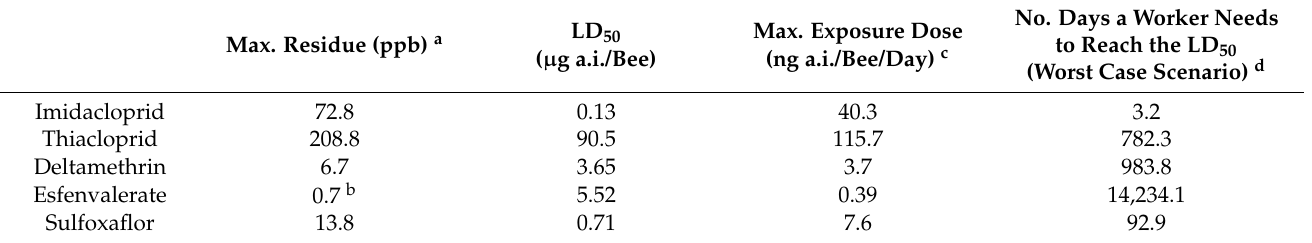
Table 2. Maximum exposure dose of B. terrestris workers to insecticides based on the maximum insecticide residues found in nectar or